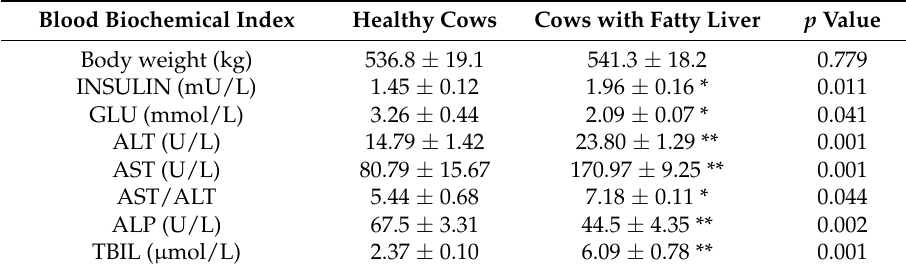
Table 1. Blood biochemical index of the healthy and fatty liver cows.